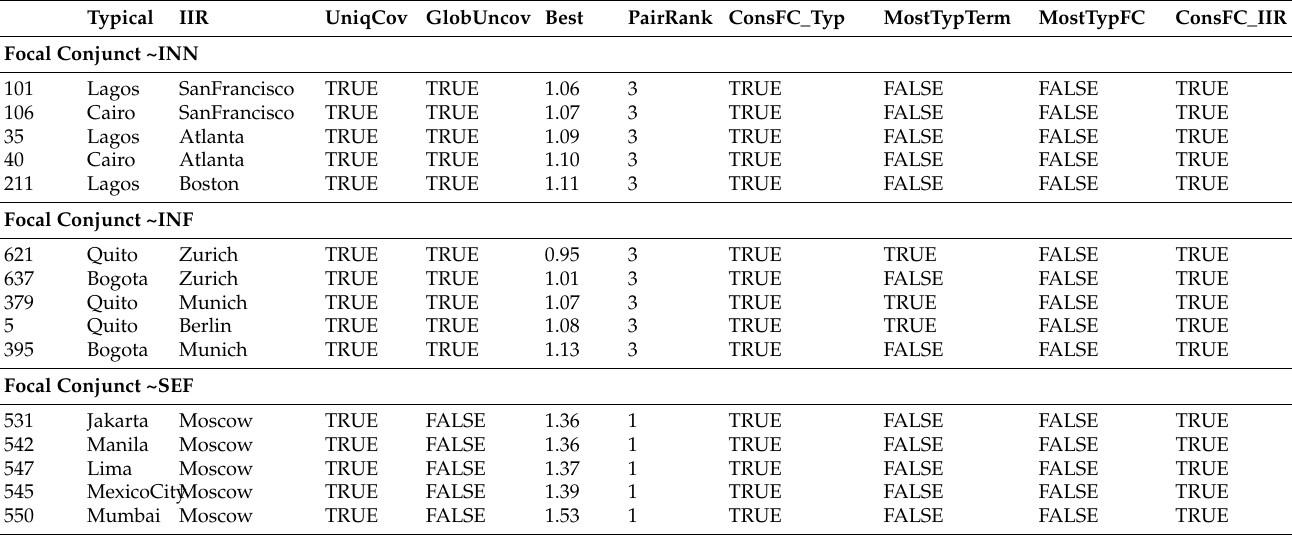
Table 9. IIR typical case Analysis for ~OVE.